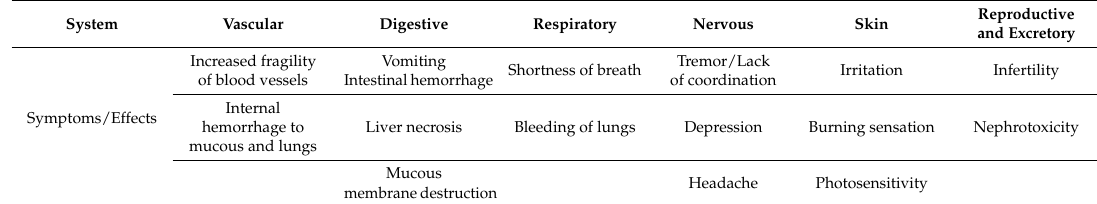
Table 1. Symptoms and effects occurred in humans and animals by mycotoxins contamination. System Vascular Digestive Respiratory Nervous Skin Reproductive and Excretory Increased fragility Vomiting Tremor/Lack of blood vessels Intestinalhemorrhage Shortness of breath of Symptoms/Effects